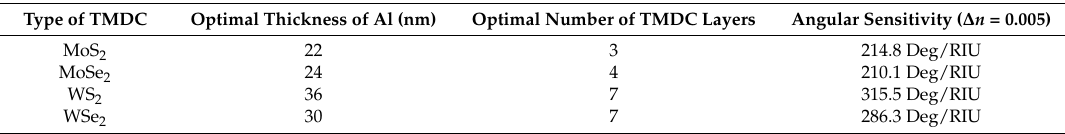
Table 2. Optimized values of thickness of gold and the number of MoS 2 layers with corresponding change in angular sensitivity.